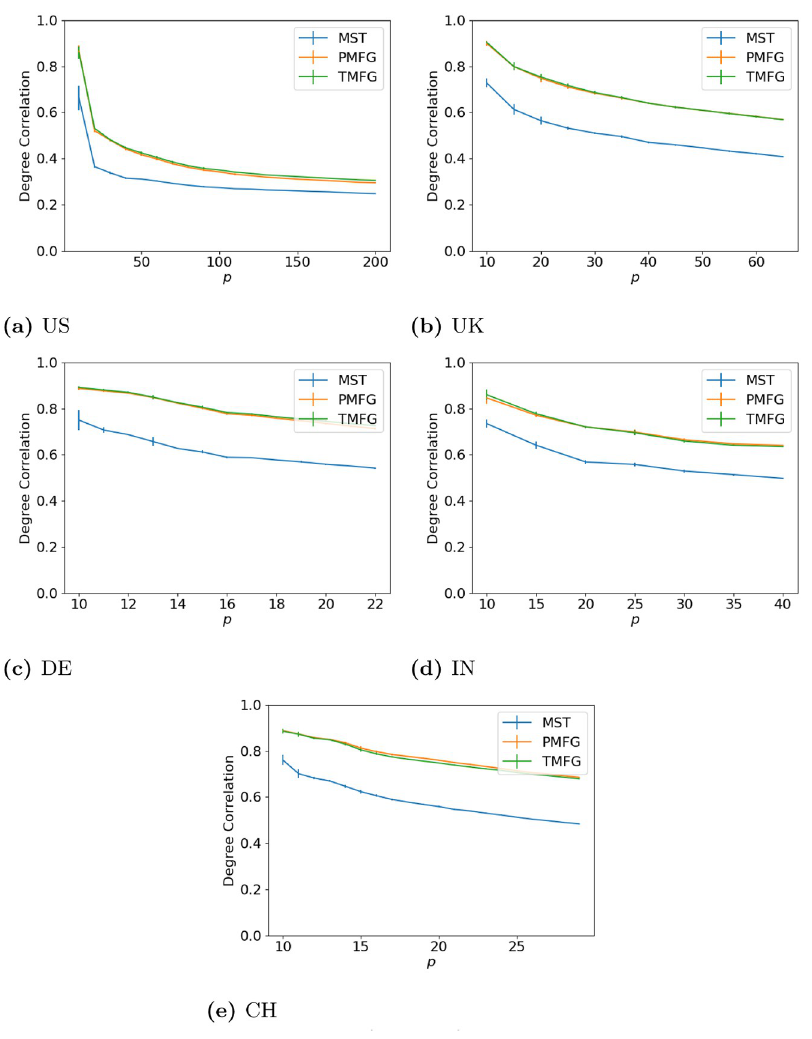
Fig 3. Degree agreement between the full and filtered correlation matrices with different values of p for the windows with minimum volatility. ( a ) US, ( b ) UK, ( c ) DE, ( d ) IN, ( e ) CH.